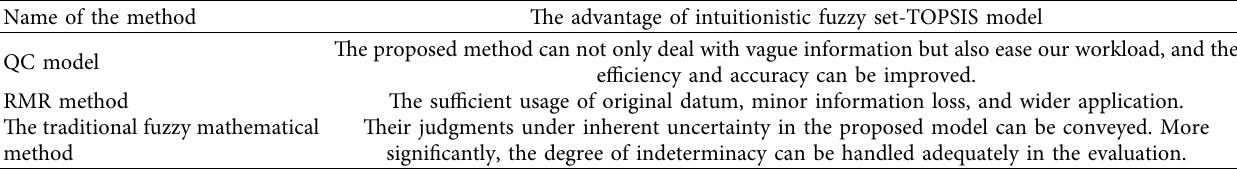
Table 6: The advantages of intuitionistic fuzzy set method over other models. Name of the